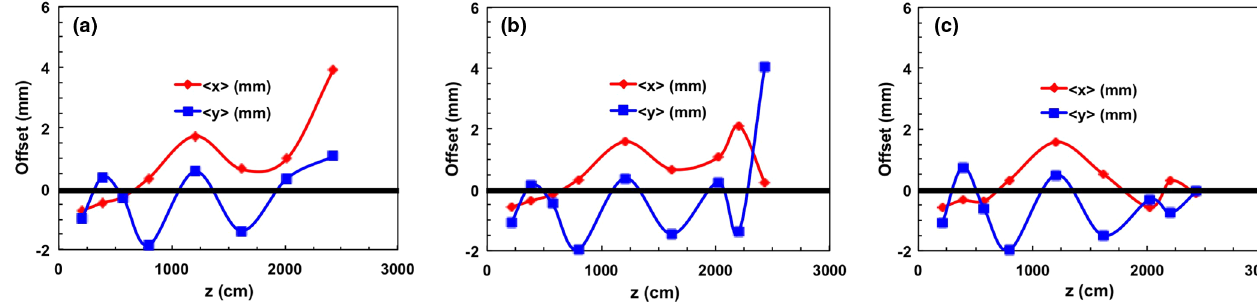
FIG. 7. Measured beam centroid offsets up to BPM14 with (a) all cells on, (b) only first 5 CB on, (c) corrected with dipoles 33 ð x; y Þ and 36 ð x; y Þ and only first five CB on. All with new A ð x; y Þ M ð x; y Þ dipole settings.